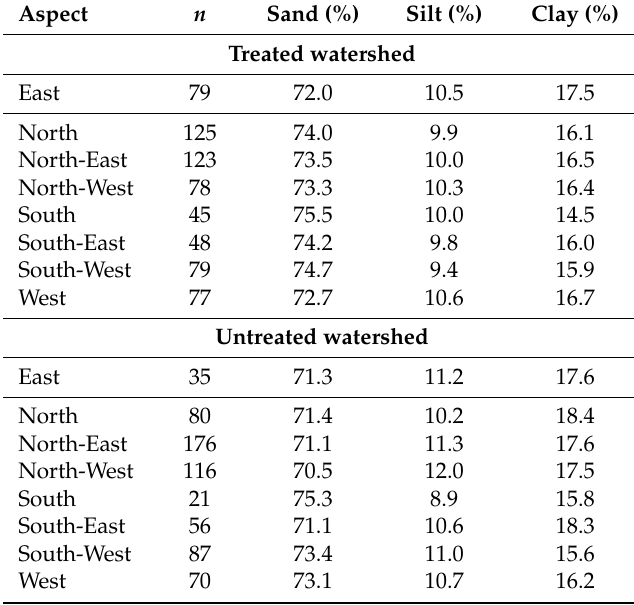
Table A3. Topsoil particle-size distribution by